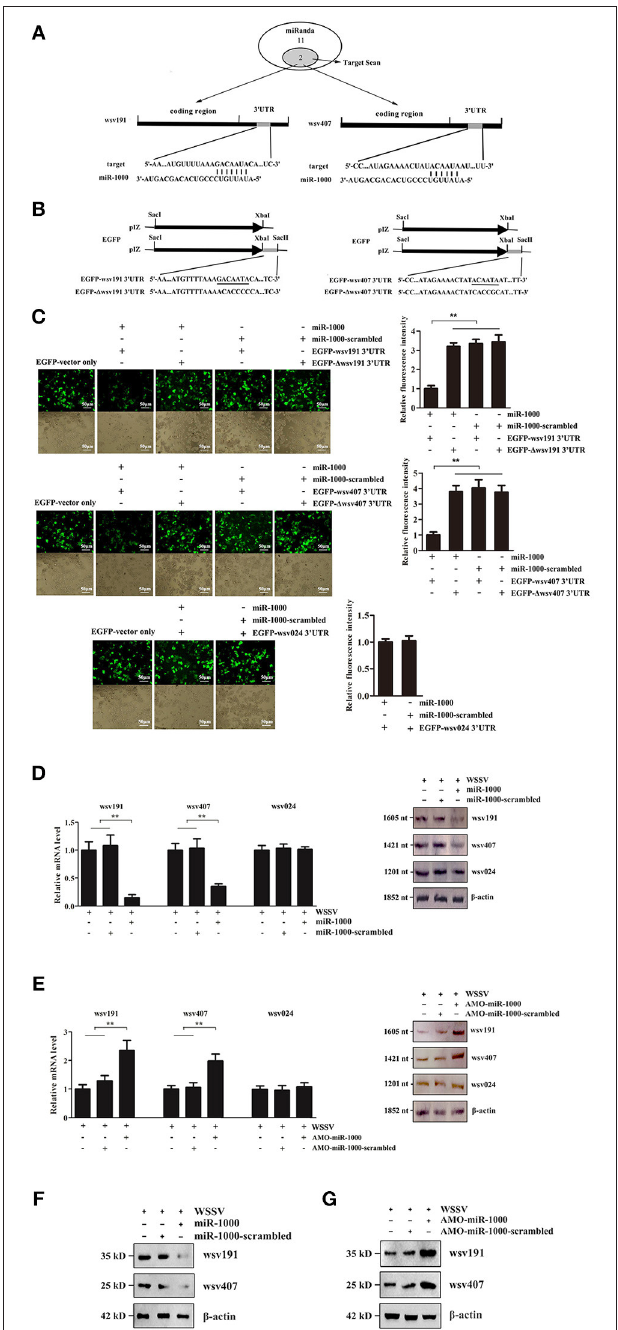
FIGURE 2 | Interaction between host miR-1000 and its target viral genes. (A) Prediction of WSSV genes targeted by miR-1000. Numbers indicated the number of potential genes predicted by the algorithms. (B) Construction of the wild-type and mutated 3 ′ UTRs of wsv191 and wsv407 genes. The sequences targeted by miR-1000 were underlined. (C) Direct interactions of miR-1000 with wsv191 and wsv407 genes in insect cells. High Five cells were co-transfected with miR-1000 and different plasmids. As controls, miR-1000-scrambled, EGFP- 1 wsv191-3 ′ UTR and EGFP- 1 wsv407-3 ′ UTR were included in the transfection. The interaction between miR-1000 and wsv024, a non-target gene of miR-1000, was also evaluated. At 48h after